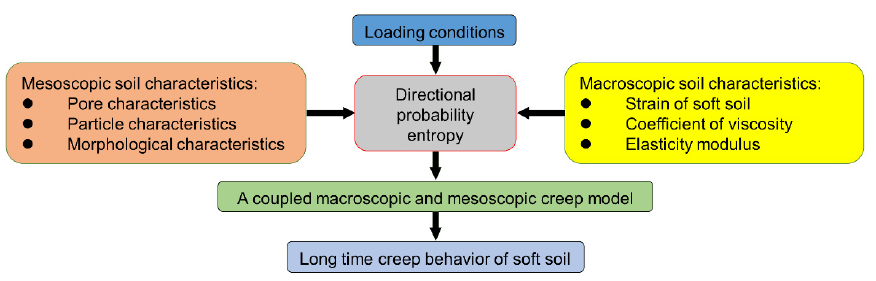
Figure 1. Schematic diagram describing the developed coupled macroscopic and mesoscopic creep model for soft marine